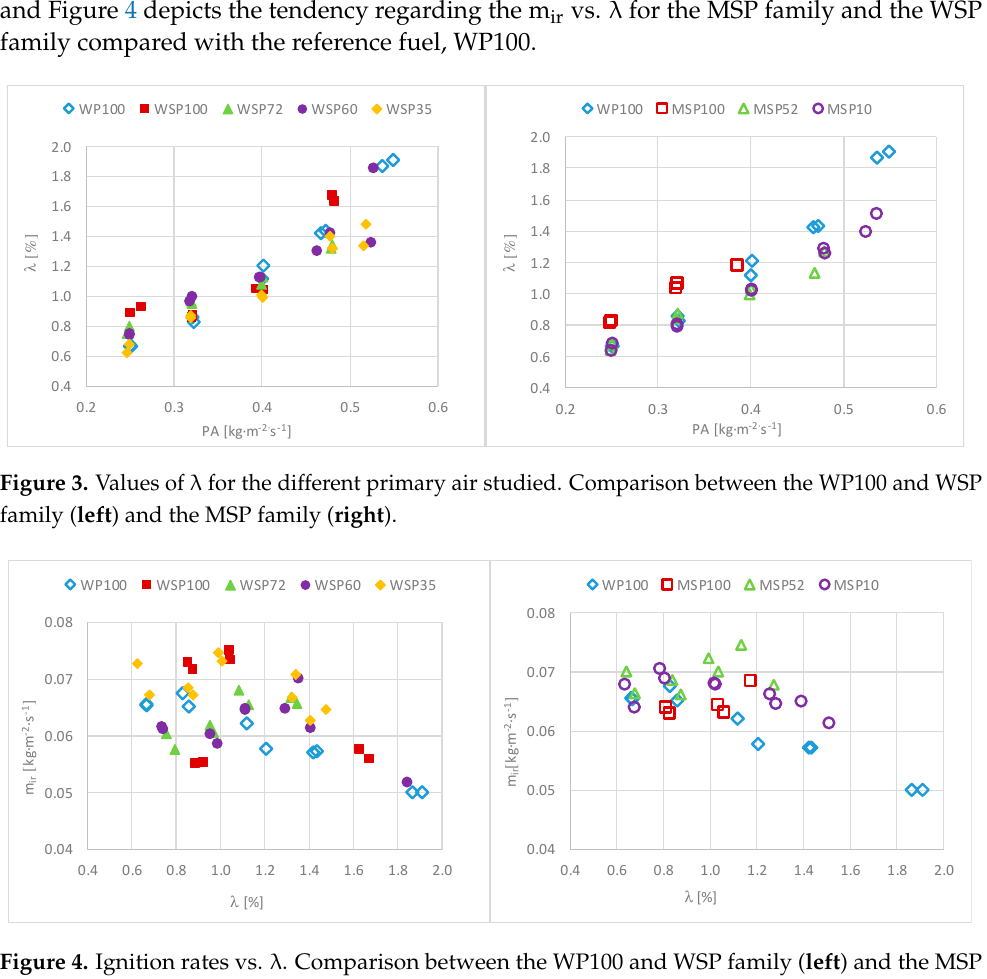
Figure 4. Ignition rates vs. λ . Comparison between the WP100 and WSP family ( left ) and the MSP family ( right